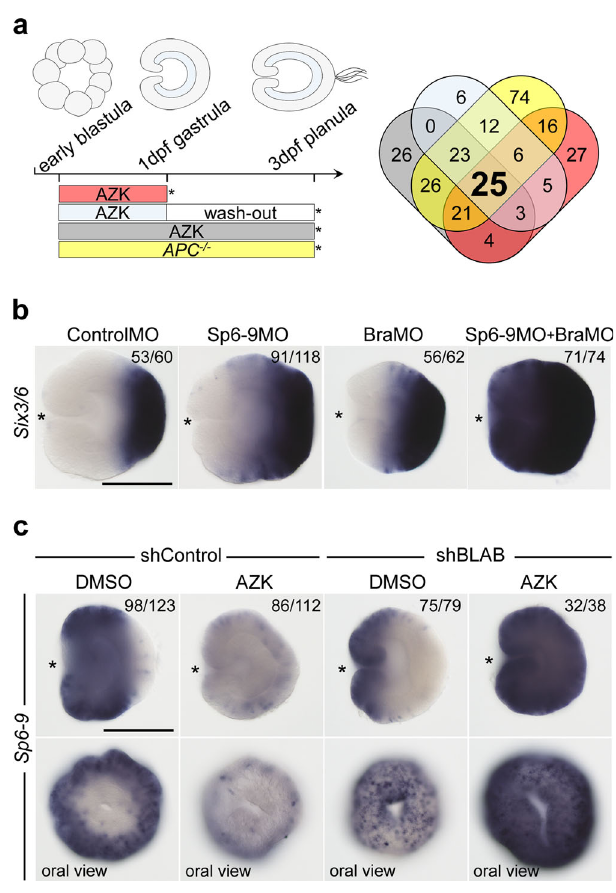
Fig. 4 Midbody domain prevents oral expansion of the aboral domain.